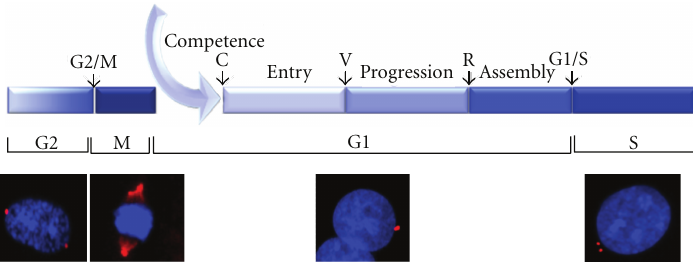
Figure 4: Progression through the G1 phase is divided into several subphases. Photographs illustrate detection of cells in G2, M, G1, and S phases: the cells were stained with DAPI (DNA) and indirect immunofluorescence detection of γ -tubulin in centrioles was used to discriminate between cells in G1 phase (a single centrosome), S phase (two centrosomes side by side), G2 (two centrioles on each side of the nucleus), and M (centrioles pulling apart the chromosomes). Four steps were identified during the G1 phase of the cell cycle: competence, entry, progression, and assembly.